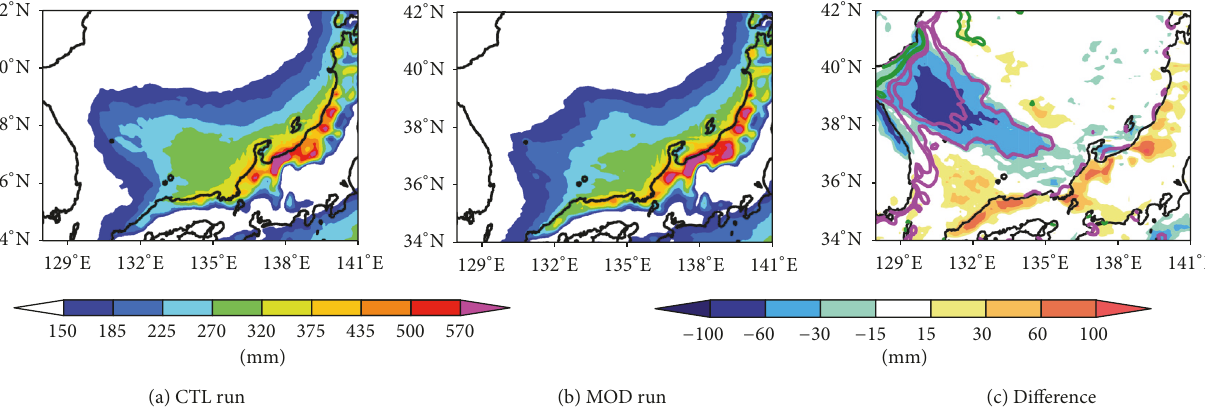
Figure 2: (a) Climatological mean December precipitation during 2000–2014 for the CTL run. (b) As in Figure 2(a) but for the MOD run. (c) Differences in precipitation (shaded) and 925 hPa horizontal wind divergence (contours) between the MOD and CTL runs (former minus latter). Purple and green contour lines denote positive and negative values, respectively. The contoured interval is 5 × 10 −6 s −1 . Values of less than 5 × 10 −6 s −1 are suppressed.